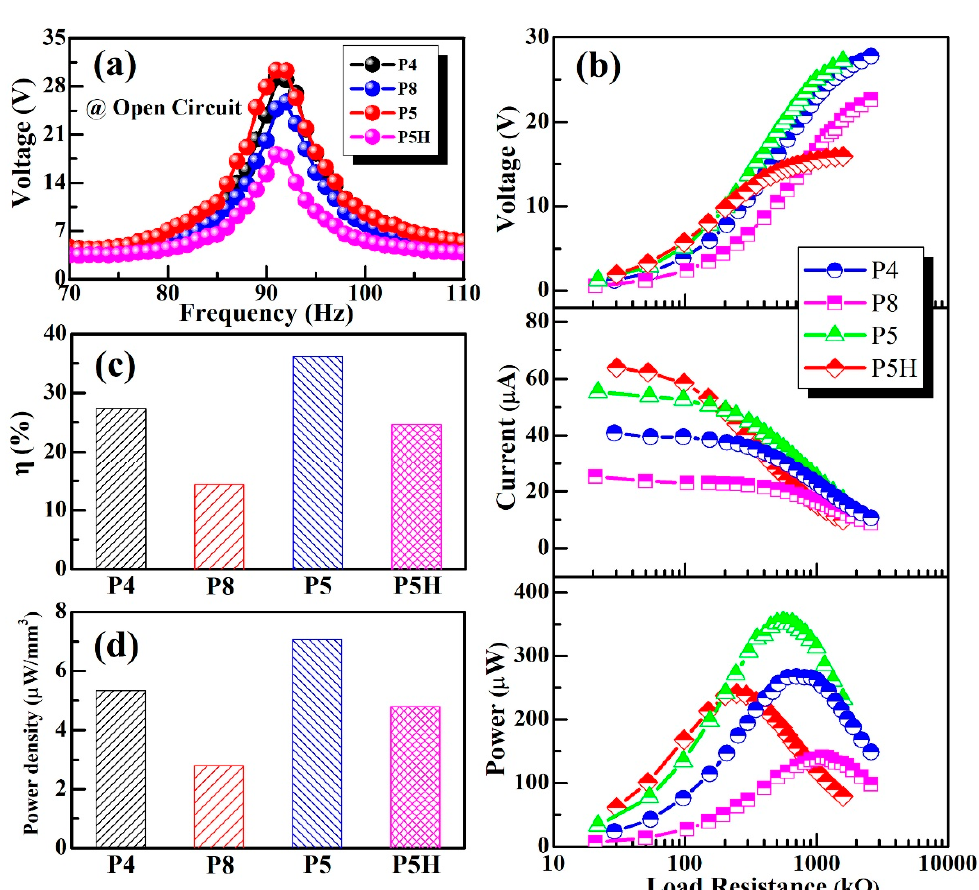
Figure 5. The experimental equipment of the piezoelectric energy harvester.